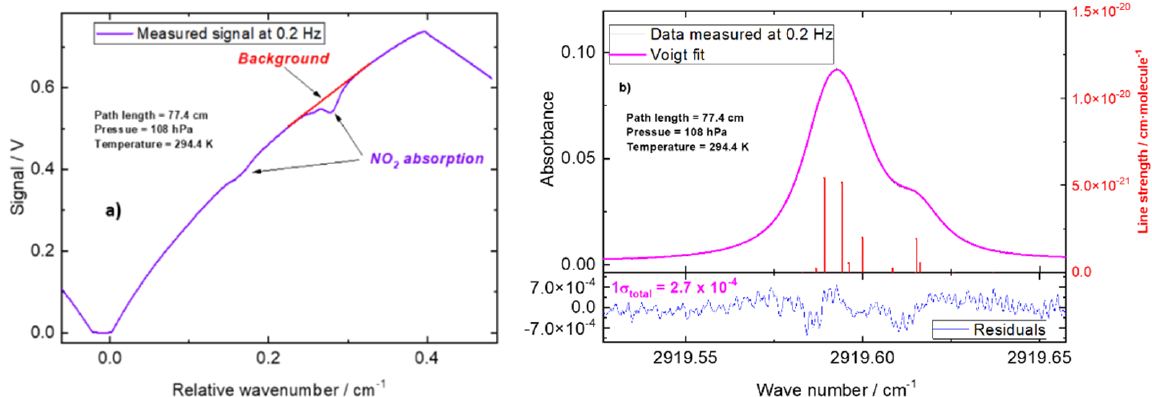
Figure 2. ( a ) Typical waves at 108 hPa signals measured using the spectrometer in Figure 1; ( b ) absorbance data derived from the data in Figure 2a. With the eight NO 2 lines shown (in red) in the line strength plot (right y axis), eight Voigt profiles are fitted to the data in order to derive the line areas.